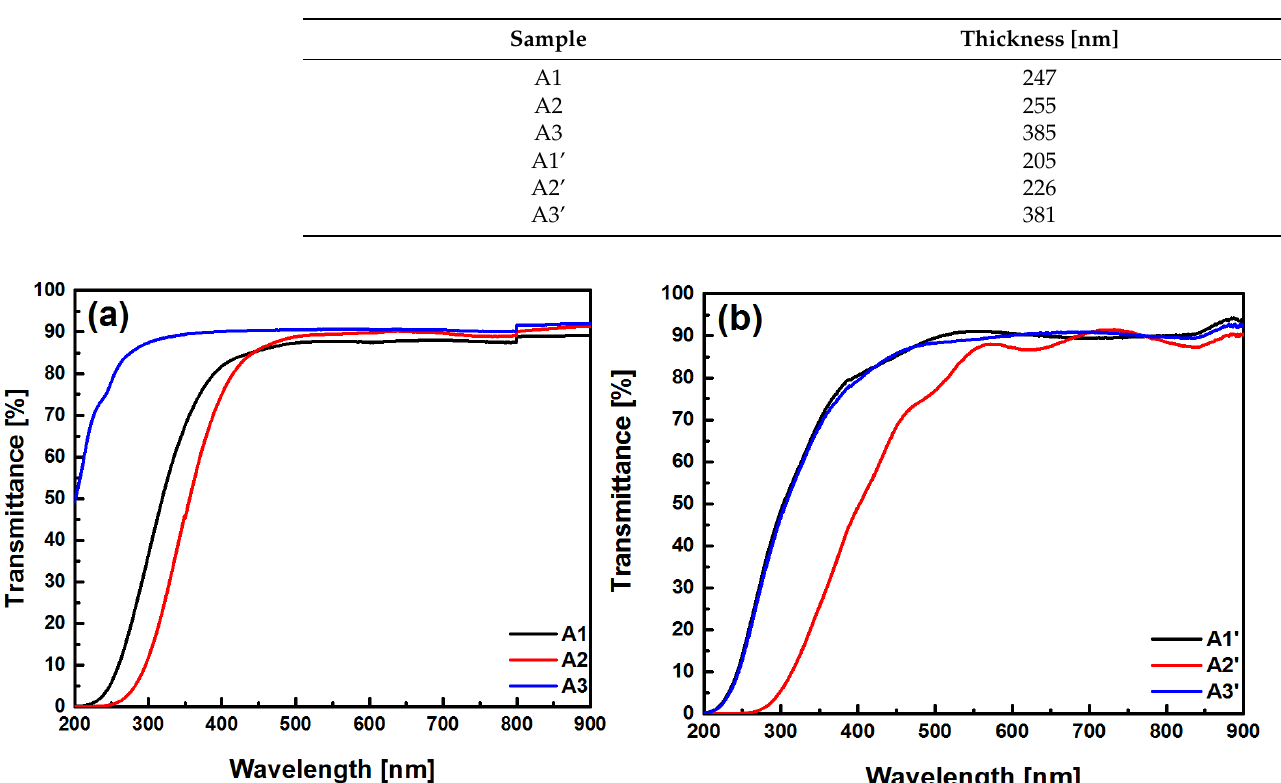
Figure 3. Transmittance the SRO films without ( a ) and with thermal annealing ( b ).